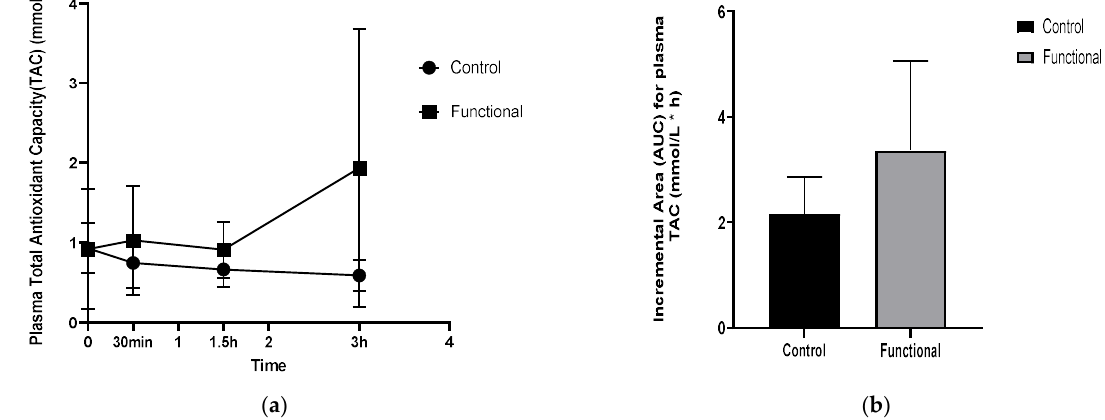
Figure 3. ( a ) Incremental changes in postprandial plasma total antioxidant capacity (TAC). ( b ) The incremental area under the curve (iAUC) for postprandial plasma TAC.